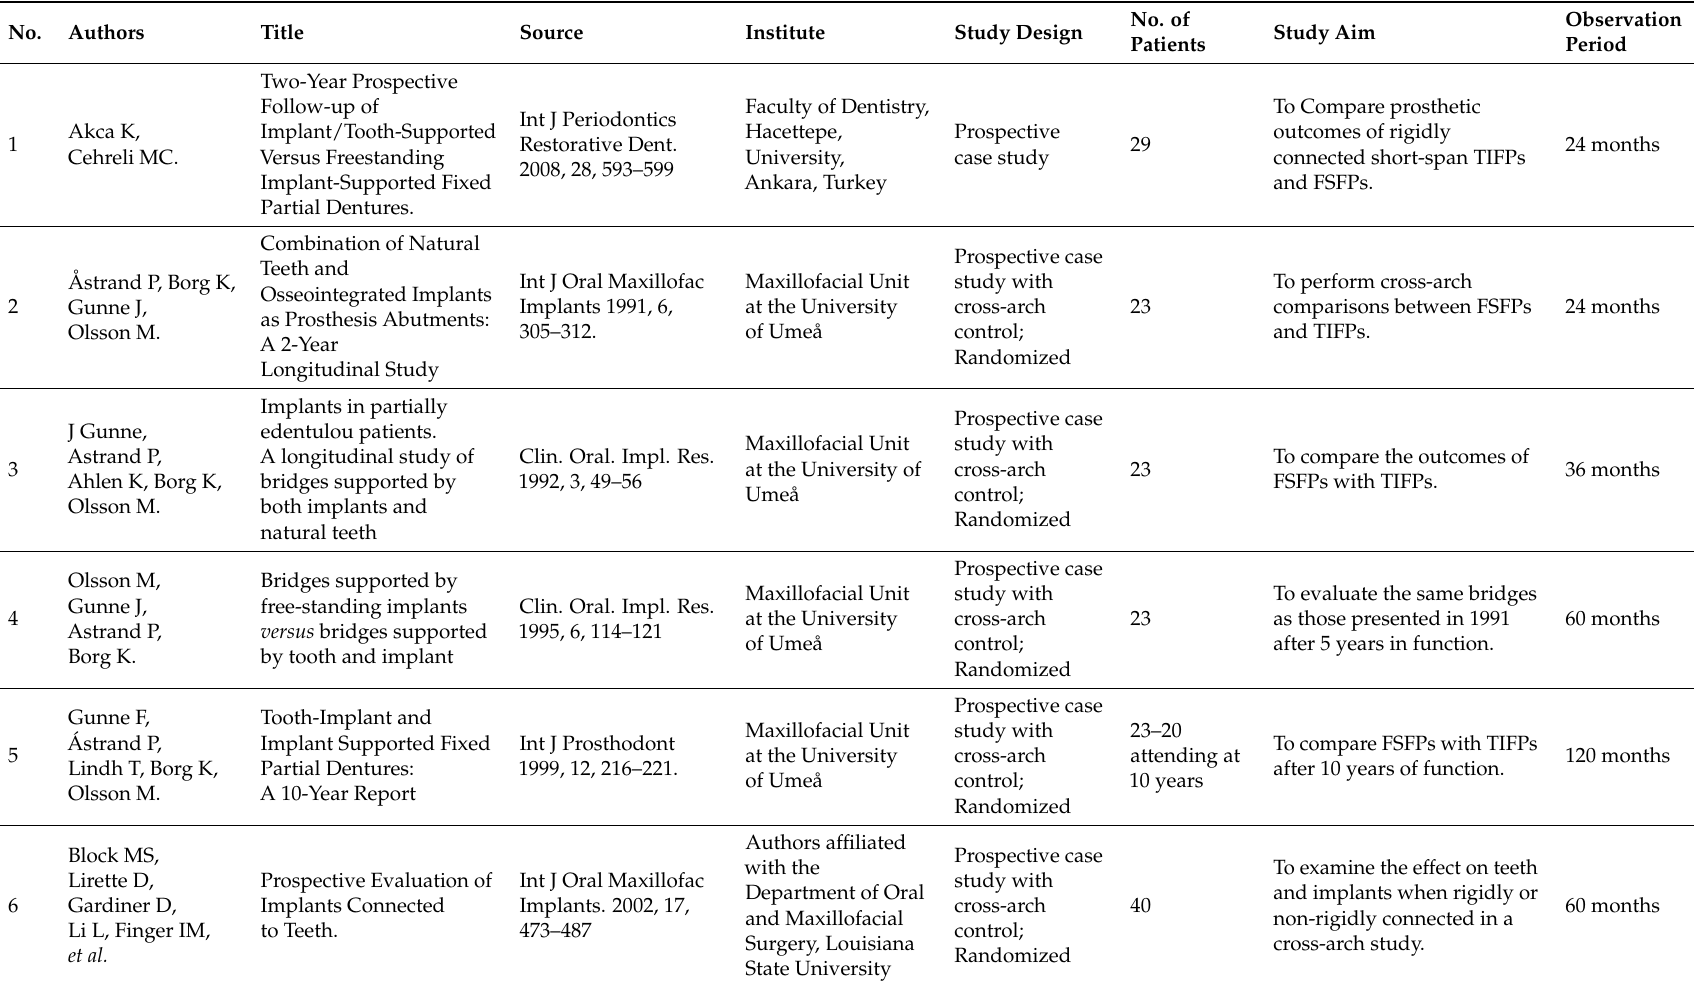
Table 2. Table of articles selected for